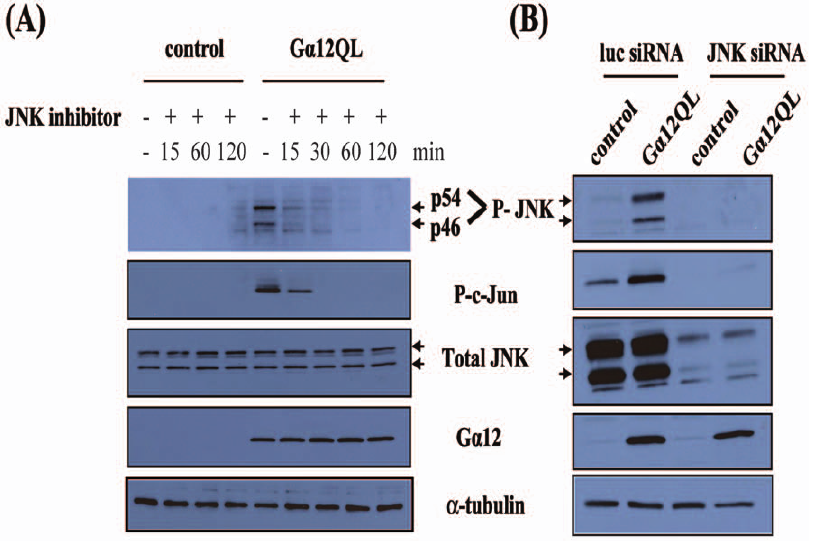
Figure 1. G a 12QL activates JNK in breast cancer cells. MDA-MB-231 cells were infected with GFP (control) or G a 12QL adenovirus for 6–7 h. (A) Cells were starved for 2 h and then treated for the indicated time with JNK inhibitor SP600125 (20 m M) prior to lysis in JNK activation buffer and processing for analysis (see Materials and Methods ). (B) Cells were transfected with JNK siRNA or control (luc) siRNA for , 72 h prior to infection with adenovirus as in (A). Cells were starved for 18 h before being lysed. For both panels, equal amounts of total protein in lysates were subjected to SDS- PAGE and immunoblot analysis to assess levels of phospho-JNK (P-JNK, p54 and p46) and phospho-c-Jun (P-c-Jun). Total levels of JNK and G a 12 expression, along with a -tubulin as a loading control, are also shown. Each panel shows the results of a single experiment that is representative of three or more independent experiments.